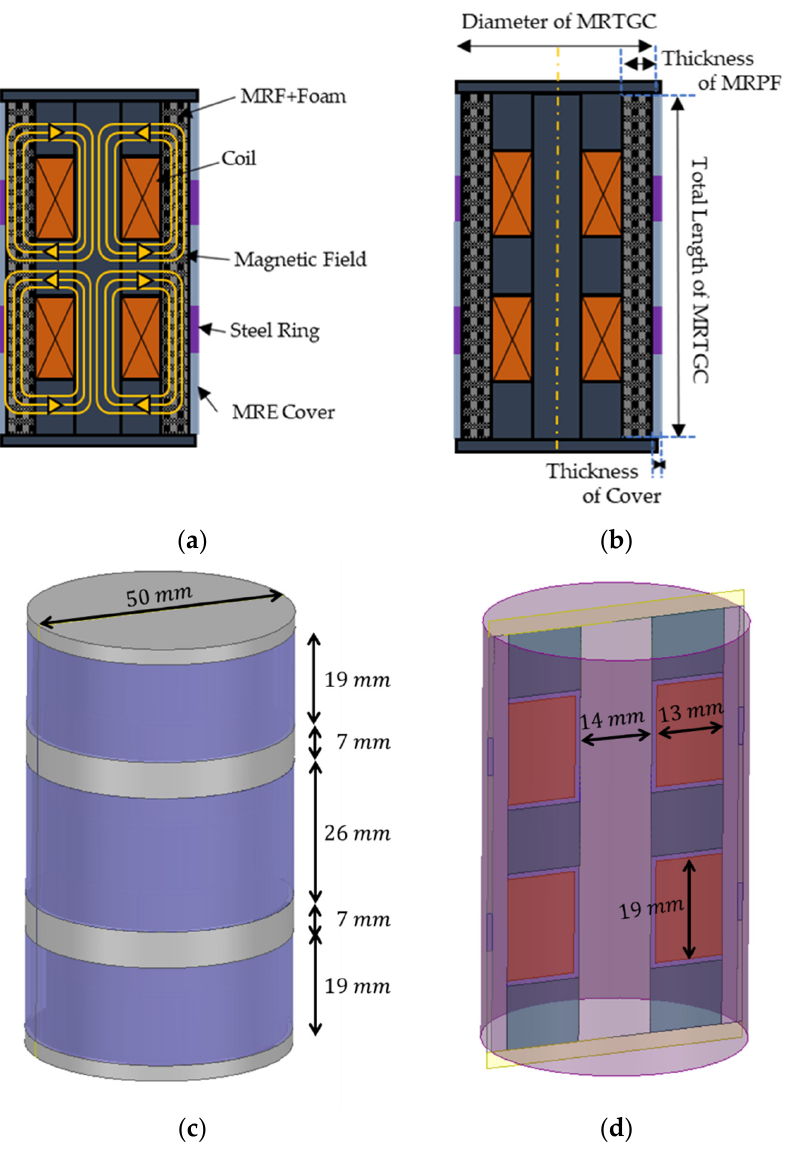
Figure 7. Magnetic core model of the tactile device: ( a ) cross-section and magnetic field formation scheme, ( b ) main design parameters, ( c ) 3D structure model of tactile device, ( d ) cross-section of 3D structure model.